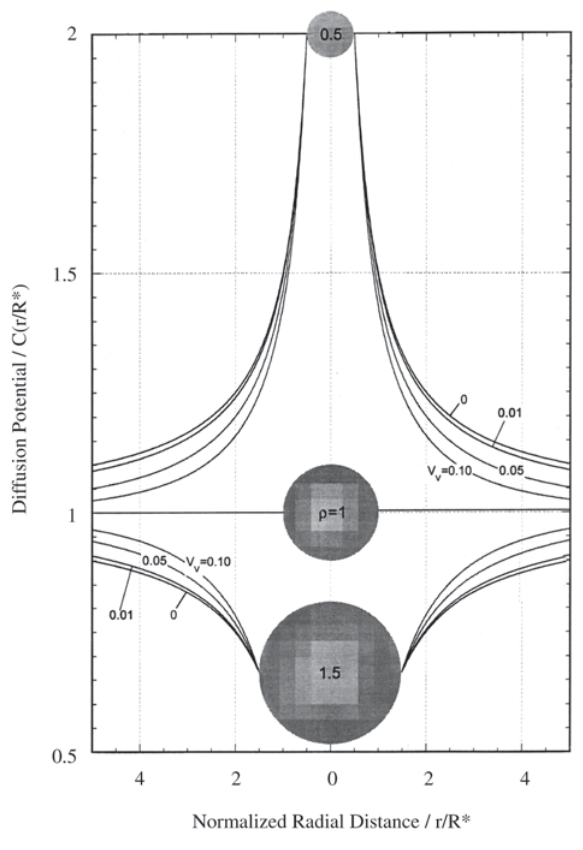
Figure 2. Influence of dispersoid volume fraction, V sion fields. Fields are shown for a small particle ( ρ = 0.5), a large particle ( ρ = 1.5), and for the critical particle ( ρ = 1). The field labeled V = 0 is that predicted from LSW theory. As V V from zero to represent real biphase microstructures, the diffusion fields decay more rapidly with increasing distance from the parti- cle centers. In addition, increasing the volume fraction steepens the gradients near larger particles, but has a relatively minor influ- ence on the gradients surrounding smaller particles. The Debye screening distance, not shown here, provides a measure of the av- erage field-decay distance for the population of particles compris- ing the